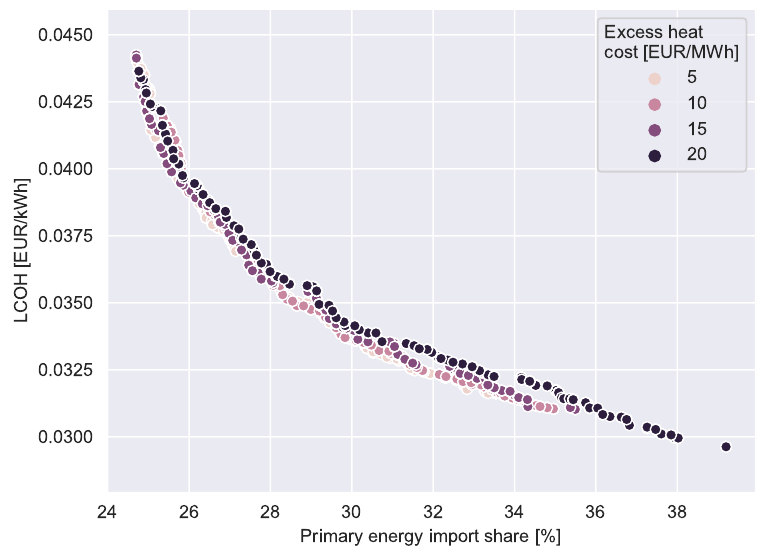
Figure 19. Comparison of the Pareto-optimal solutions for the different excess heat cost scenarios. The network temperatures are fixed at 55/35 ◦